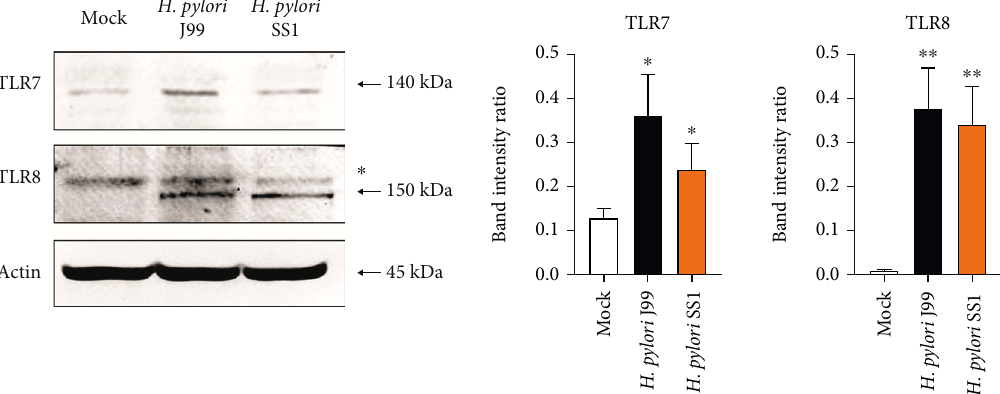
Figure 2: H. pylori induces TLR7 and TLR8 protein expression in THP-1 cells. Western blot analysis of protein lysates prepared from uninfected THP-1 cells (mock) or cells infected with H. pylori J99 and SS1 strains at a MOI of 10 for 16 hours. Membranes were probed with antibodies against TLR7, TLR8, and control β -actin. Asterisk ( ∗ ) indicates nonspeci fi c band; arrow indicates bands of interest. (a) Western blot data. (b) Bar charts showing average ratio of TLR7 or TLR8 over β -actin band intensities. Data are representative of two independent experiments and shown as mean ± SD . Statistical signi fi cance was analyzed using Student ’ s t -test ( ∗ P ≤ 0 : 05 ; ∗∗ P ≤ 0 : 01